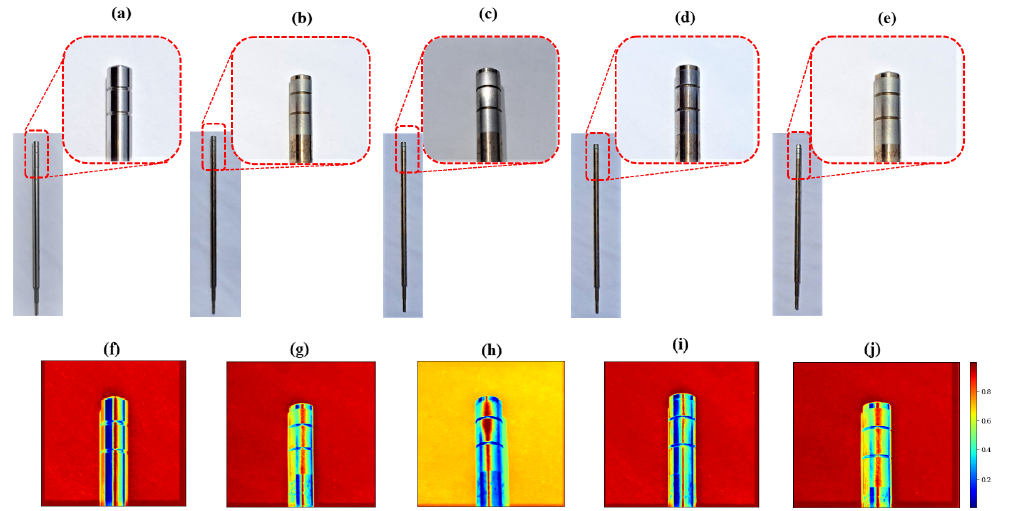
Figure 6. Comparison of injector valve pistons between ( a ) normal injector; ( b – e ) worn injectors after experiment, and ( f – j ) surface profiles for respective injector valve pistons.